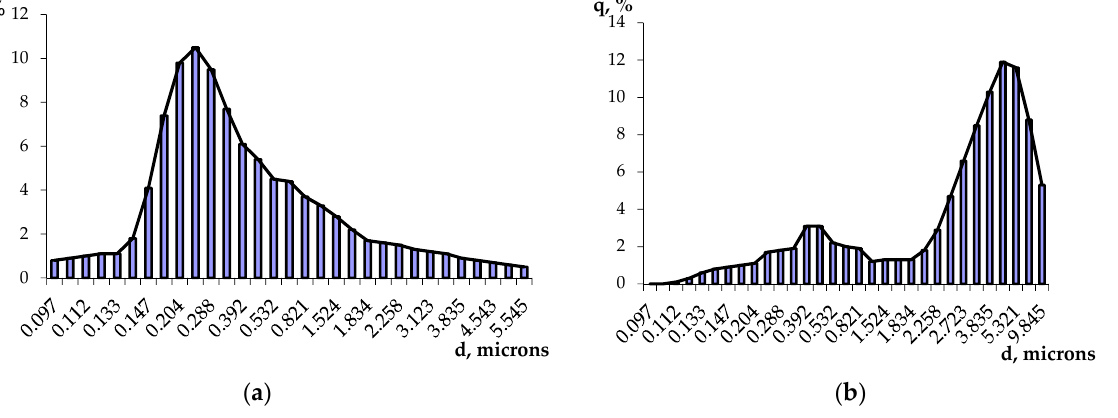
Figure 6. Distribution curves of fi ne slag particles in suspension after ultrasonic processing: ( a ) at t = 25 °C; τ = 15 min; ( b ) at t = 50 °C; τ = 15 min.